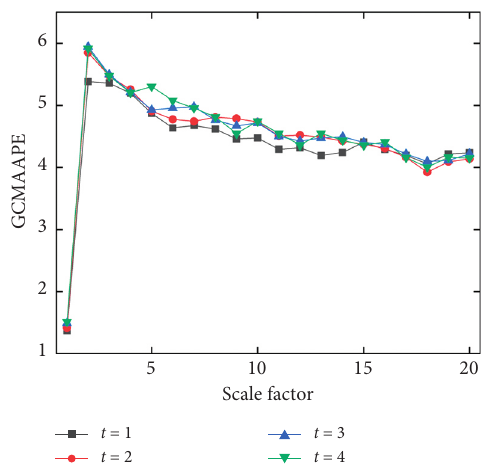
Figure 4: Effect of embedding dimension on the performance of GCMAAPE.